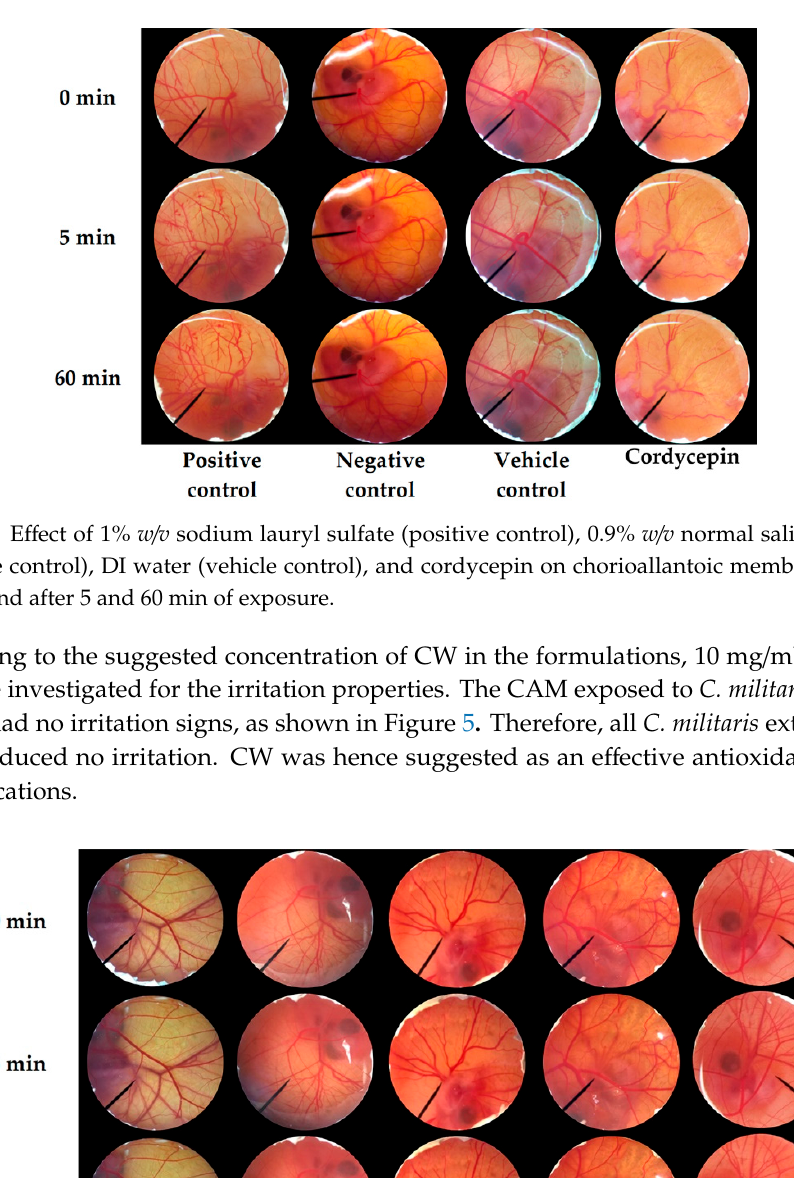
Figure 5. Effect of C. militaris extracts, including hexane extract (CH), ethyl acetate (CA), ethanolic extract (CE), crude ethanolic extract (CC), and water extract (CW) on chorioallantoic membrane before (0 min) and after 5 and 60 min of exposure.